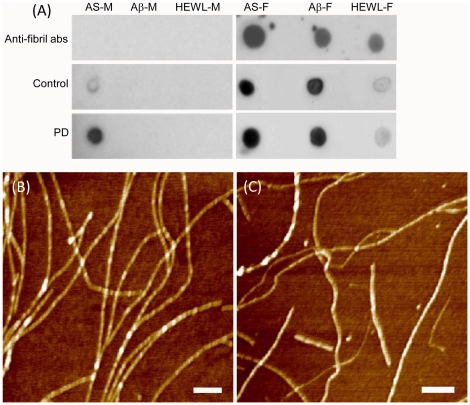
Immune reactivity of pooled IgGs from the blood sera of controls and PD patients towards monomers and amyloid fibrils of different polypeptides measured by dot blot analysis.(A) Dot blots demonstrating the immune reactivity towards monomers of α-synuclein (AS-M), Aβ peptide (Aβ-M) and hen egg white lysozyme (HEWL-M) are shown in the left panel and towards corresponding fibrils (AS-F, Aβ-F and HEWL-F) – in the right. The rows of dot blots from top to bottom show the interactions of antigens with added anti-fibrillar antibodies [6] and pooled IgGs from the sera of controls and all PD patients, respectively. AFM images of amyloid fibrils of Aβ peptide (B) and hen egg white lysozyme (C) subjected to dot blot analysis. Scale bars in x,y-plain equal to 500 nm.